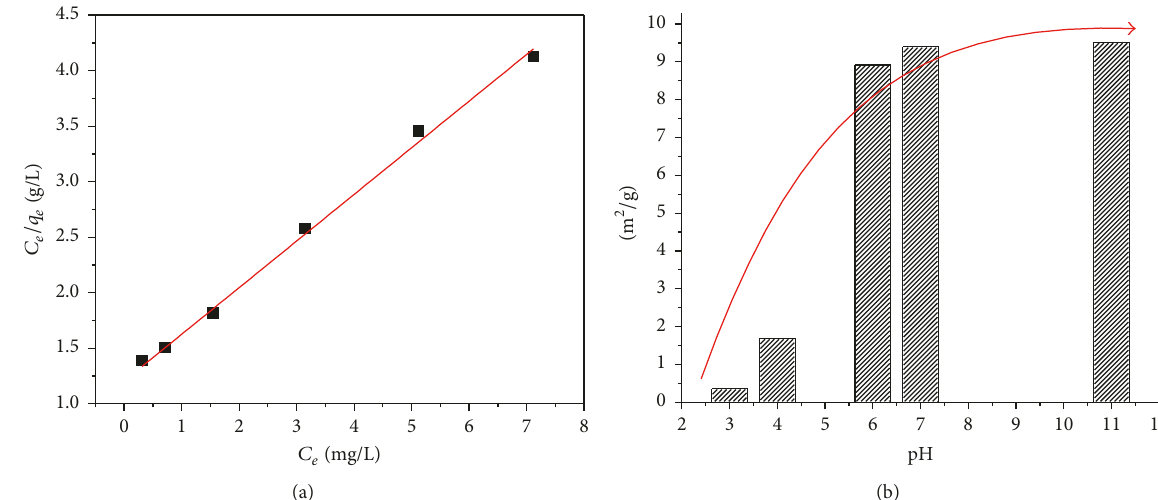
Figure 6: (a) The 𝐶 𝑒 /𝑞 𝑒 versus 𝐶 𝑒 plot for MB adsorption onto spent LIB cathode. (b) The surface area measured by MB adsorption with pH variation.